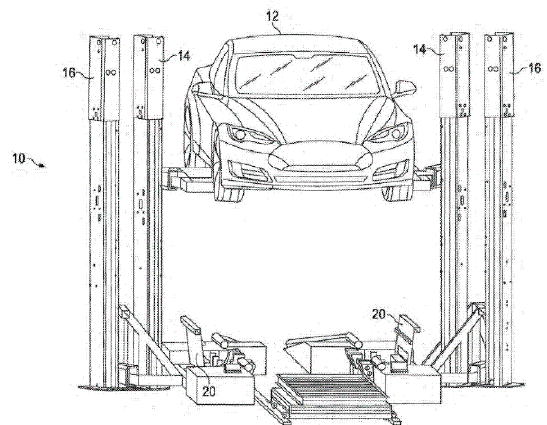
Figure 3. Battery swapping procedure flow chart [15].